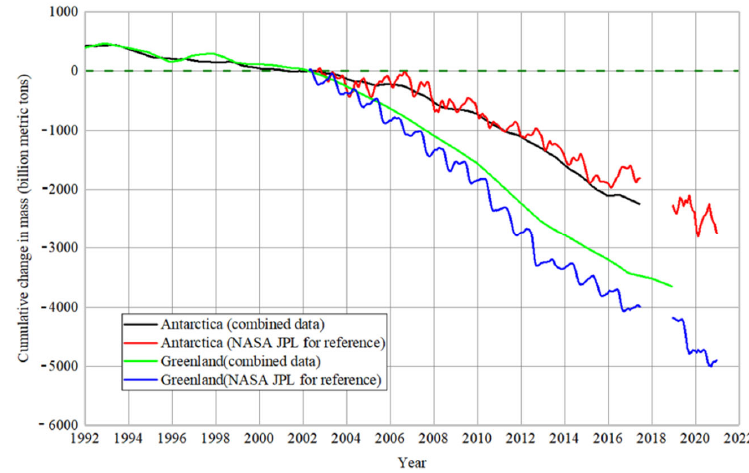
Figure 1. Cumulative mass balance of Greenland and Antarctica, 1992–2020.